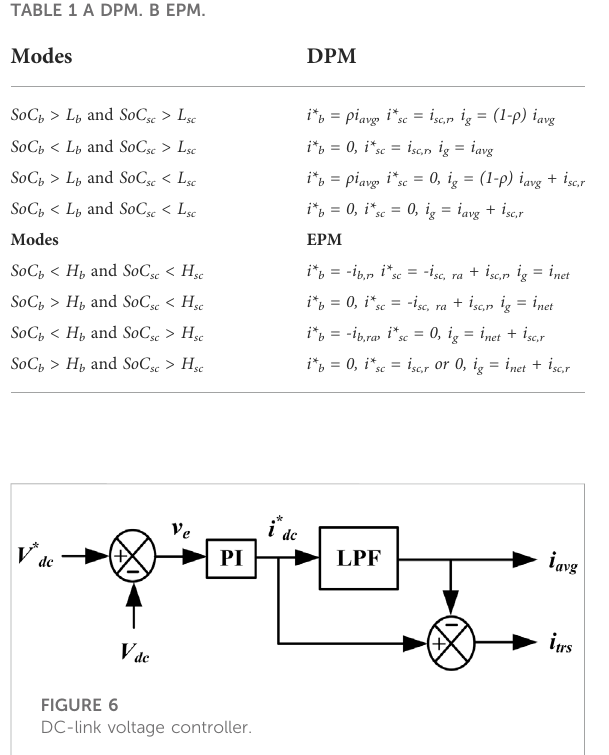
FIGURE 6 DC-link voltage controller.